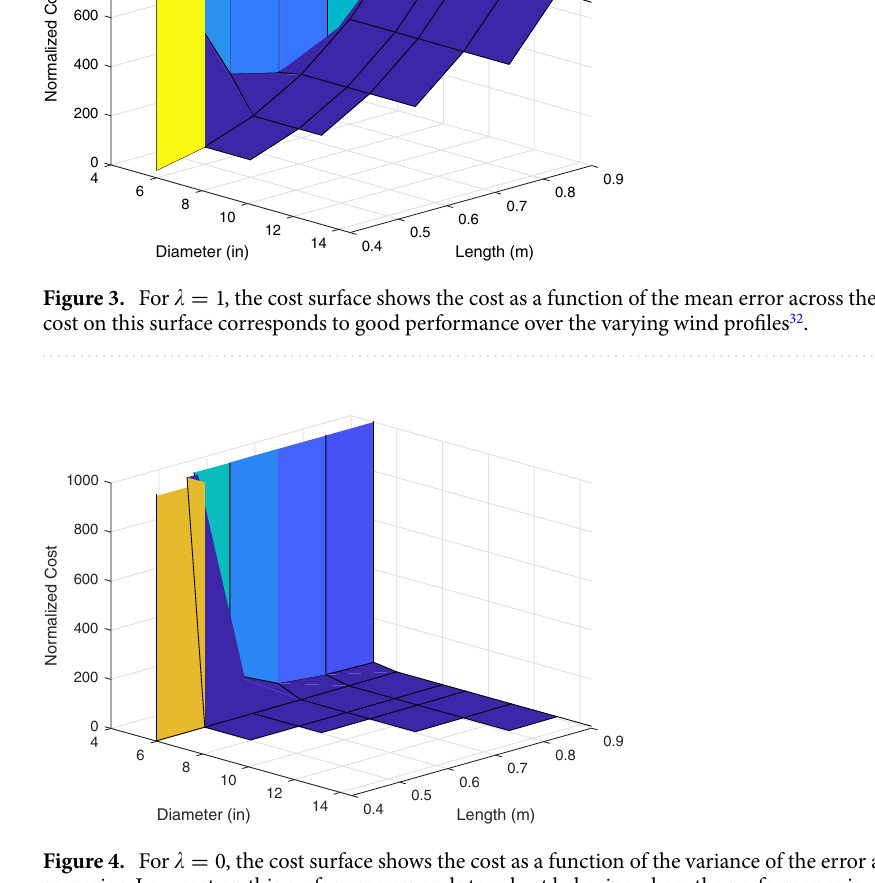
Figure 4. For (cid:31) = 0 , the cost surface shows the cost as a function of the variance of the error across the scenarios. Low cost on this surface corresponds to robust behavior where the performance is very consistent across the wind profiles 32